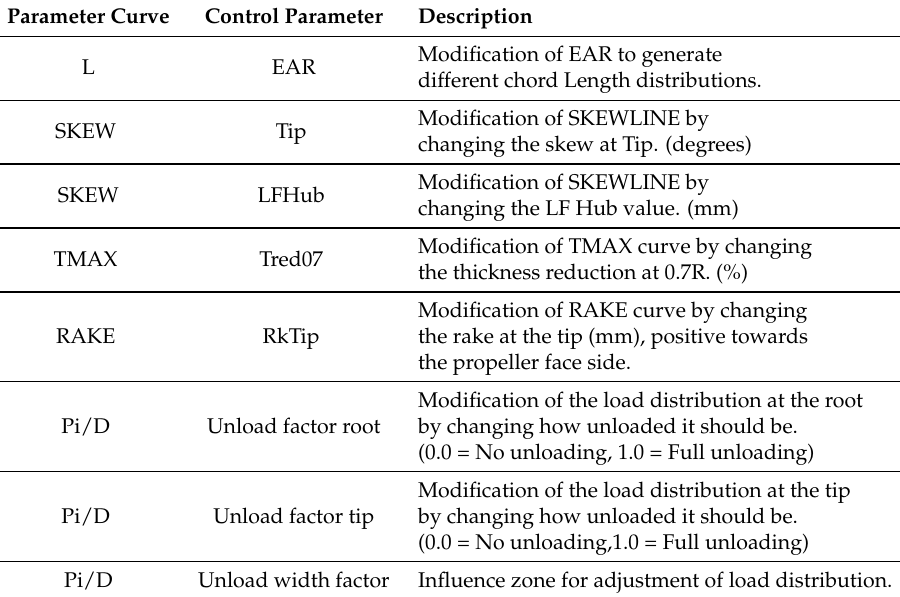
Table 2. Standard distribution curves and their corresponding controlling